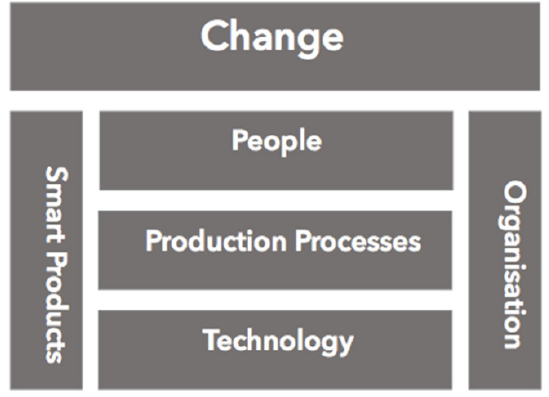
Figure 1. Proposed framework’s structure.